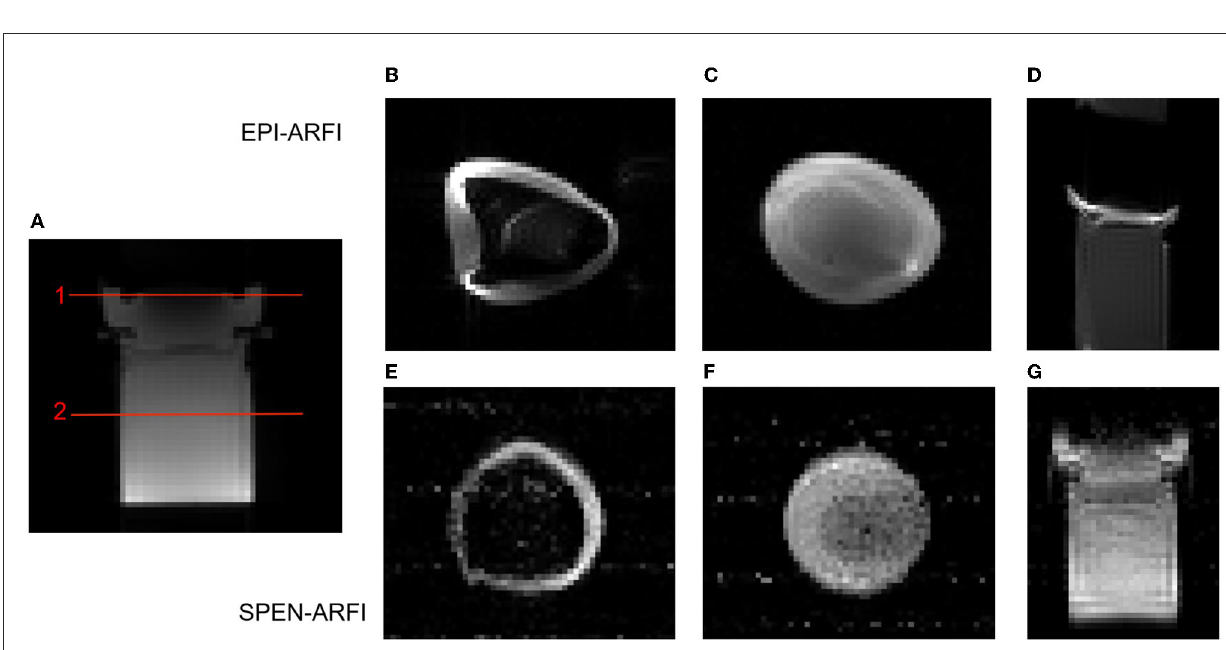
FIGURE7 Comparison of EPI-ARFI and SPEN-ARFI sequences under inhomogeneous field. Red lines represent two different slices: Slice 1: (B, E) ; Slice 2: (C, F) . (A) SE-ARFI in coronal. (B, C) EPI-ARFI in axial. (D) EPI-ARFI in coronal. (E, F) SPEN-ARFI in axial. (G) SPEN-ARFI in